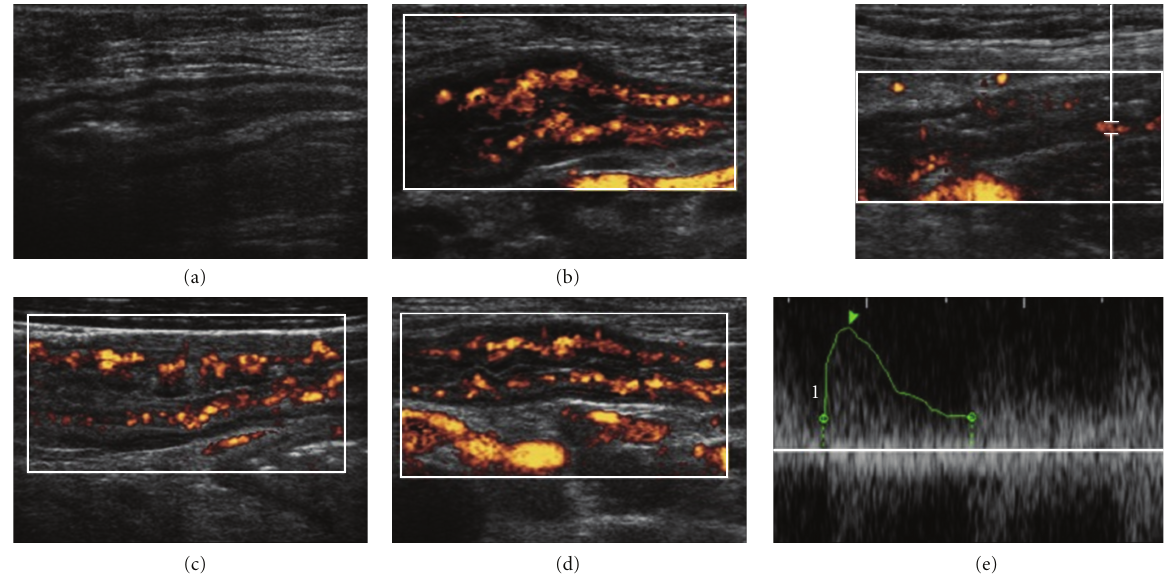
Figure 3: PDs. Wall thickening in B mode (a), in PD (b), (c), (d), and arterial doppler spectrum (e).